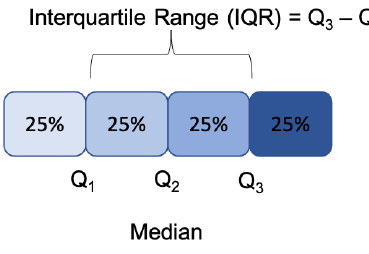
Figure 4. The interquartile range